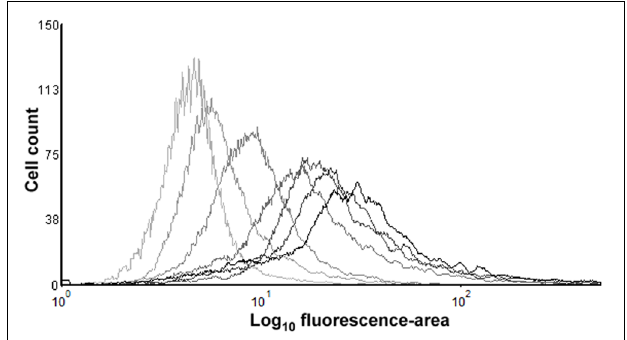
FIGURE 8 | Median values ( ) of the fluorescence-area values obtained from single cell-flow cytometry from PI-stained cells and (cid:32) their linear regression lines, plotted against each duration of the thermal treatment at 53 ◦ C. The graph also shows the log 10 cycles of inactivation (-log 10 cycles of the survival fractions) as measured in M9 agar with 3% NaCl (red bars, corresponding to right Y-ax). Error bars represent standard deviation of the mean from three